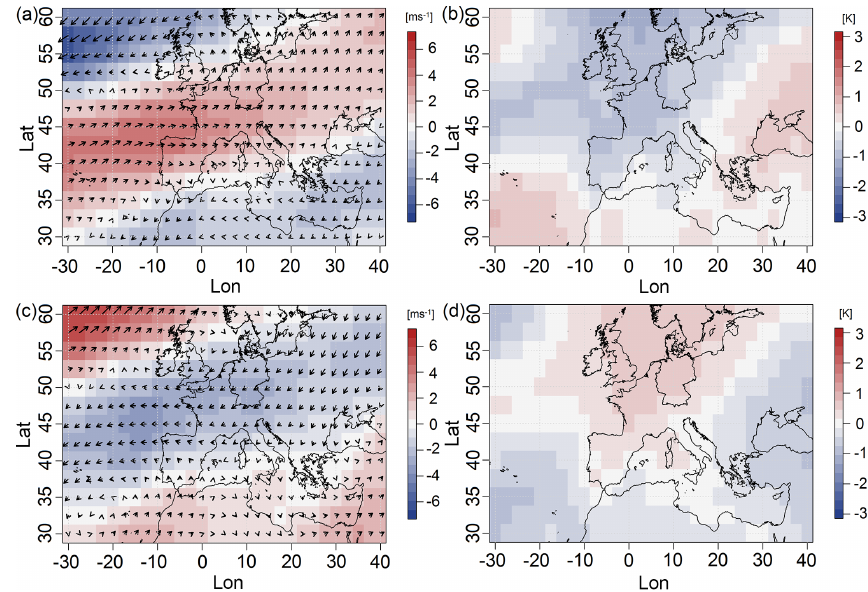
Figure 13. Average anomaly of (a) wind vector and horizontal velocity in 300hPa, and (b) equivalent potential temperature θ e in 850hPa during negative NAO phases. (c, d) as (a, b) , but for positive NAO